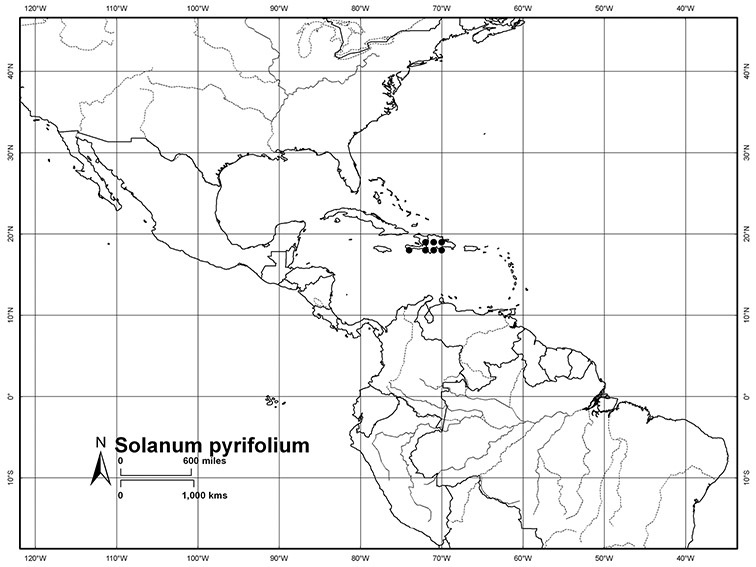
Distribution of Solanumpyrifolium Lam.